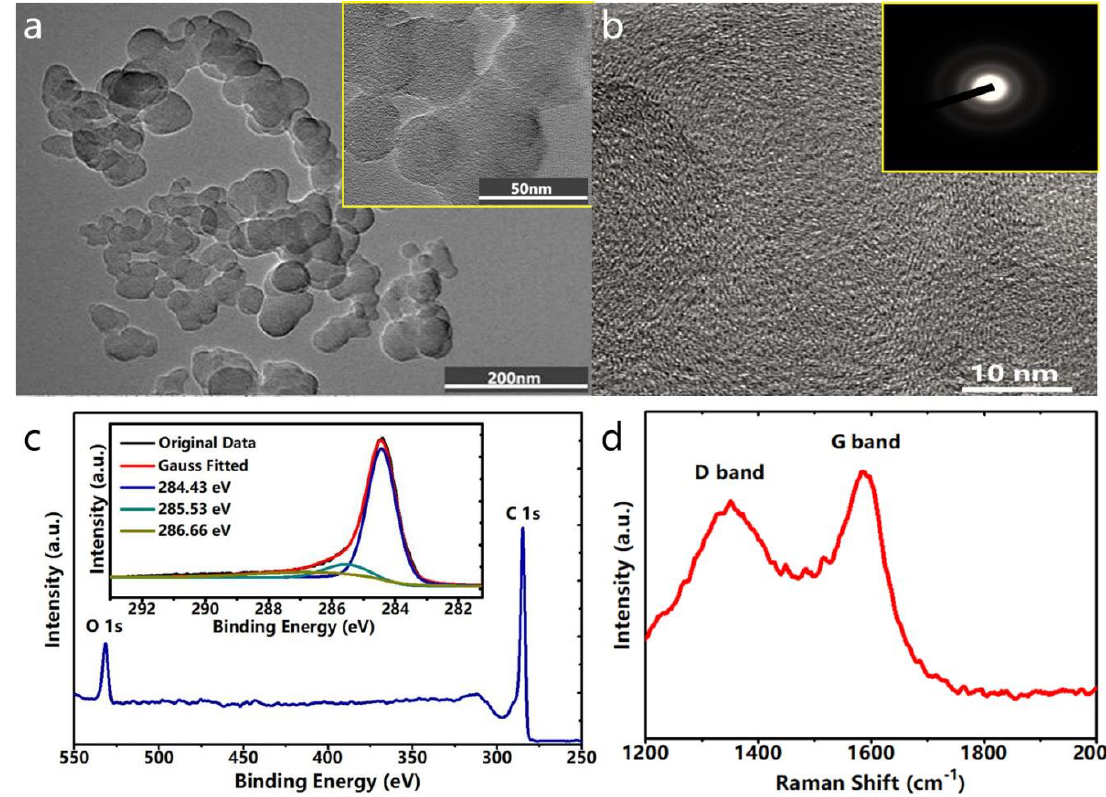
Figure 2. ( a ) TEM image of NCB and its higher magnification (inset). ( b ) High-resolution TEM image of the NCB and its SAED pattern (inset). ( c ) XPS spectrum showing the O 1s and C 1s peaks of the NCB. The inset in the panel shows the deconvolution of the C 1s XPS peak. ( d ) Raman spectrum of NCB.